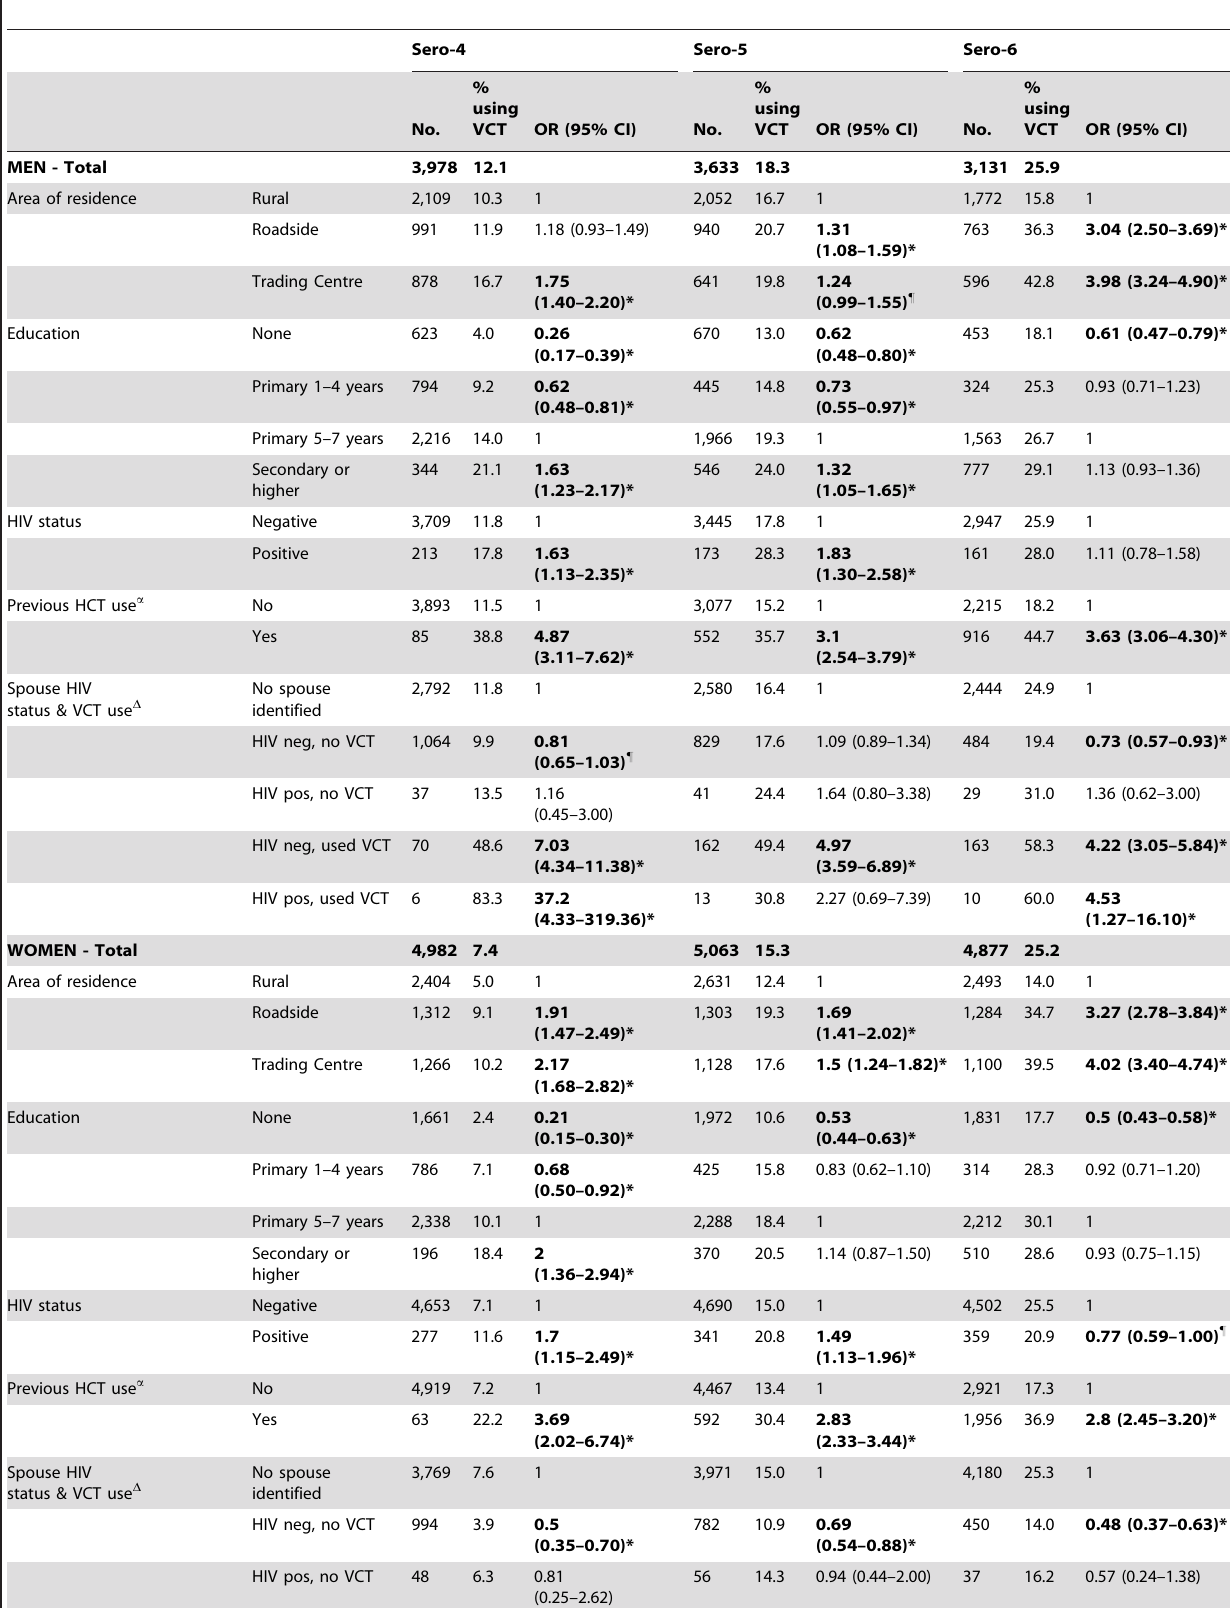
Table 1. Univariable analysis of factors most strongly associated with VCT uptake at sero-surveys 4, 5 and 6